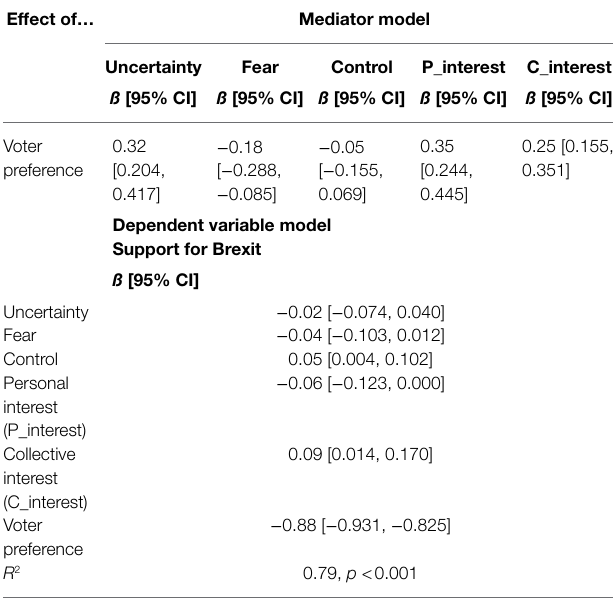
TABLE 3 | Direct effects of voter preference and motives on support for Brexit (Study 1).